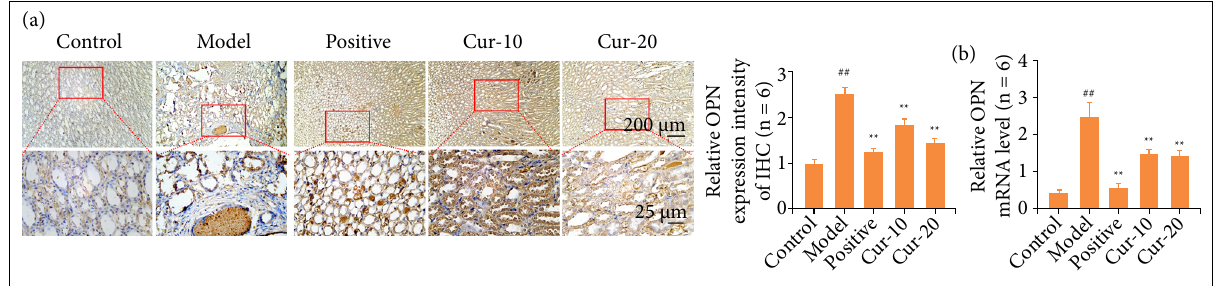
Figure 5 – Detection of the expression of OPN in kidney tissue. (a) OPN immunohistochemical staining results (n = 6). Compared with the control group, the expression of OPN in the model group was obvious. The positive expression of OPN was in a small aggregate state; (b) Relative gene expression of OPN (n = 6). The normality test was performed using Shapiro–Wilk, differences between two groups were measured by Student’s t-test. * P < 0.05, ** P < 0.01 means comparison with model group, ## P < 0.01 means comparison with the control